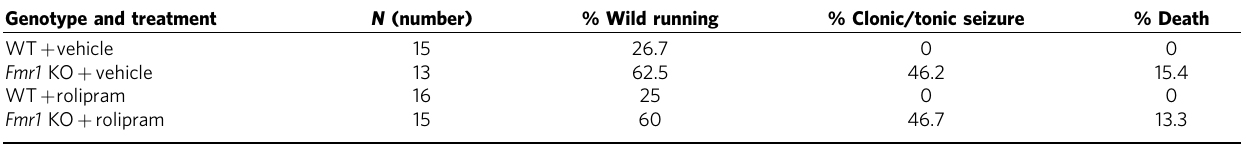
Table 3 | Acute administration of rolipram has no significant effect on audiogenic seizures. Genotype and